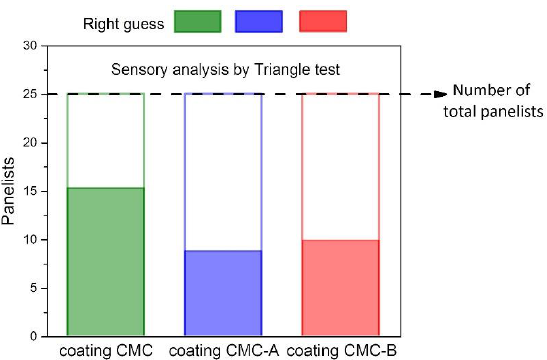
Figure 8. Sensory analysis results of the fresh goldenberries (coated and uncoated) using a Triangle sensory test. According to the test, the number of correct answers to establish a significant difference at a 95% confidence level should be ≥13 for 25 tasters.